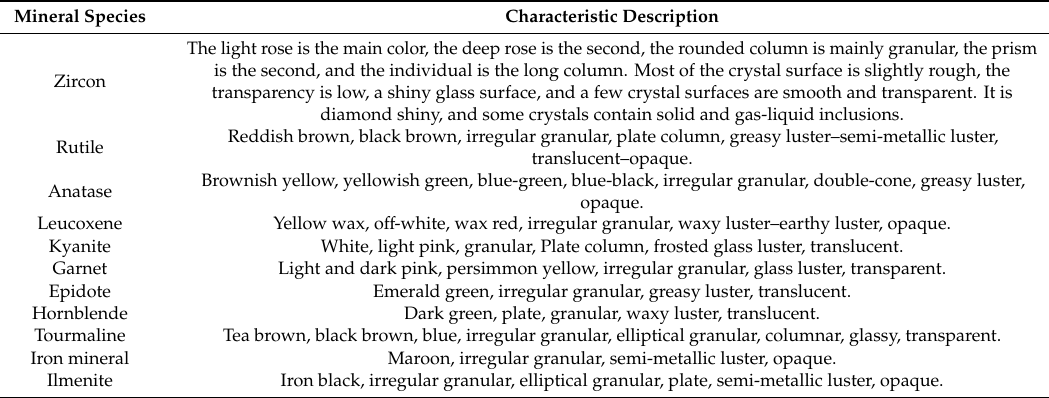
Table 2. The description of heavy mineral